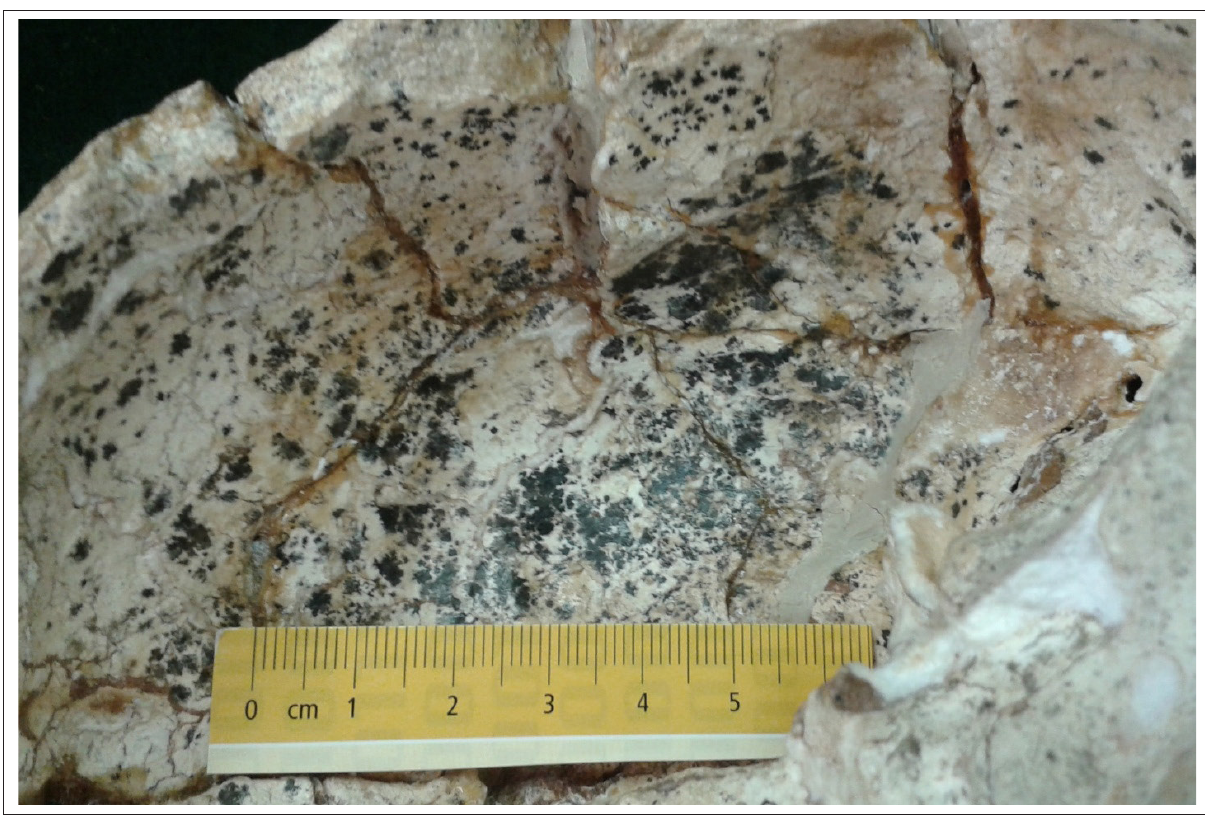
Figure 5: Manganese oxy-hydroxide spots on the inner cranial bone of Stw 505 ( Australopithecus africanus ) from Sterkfontein. It is suggested that the spots relate to the temporary growth of lichen before the cranium was covered by sediment, when lichen growth would have ceased in the absence of light. Photograph: Francis Thackeray (University of the Witwatersrand).